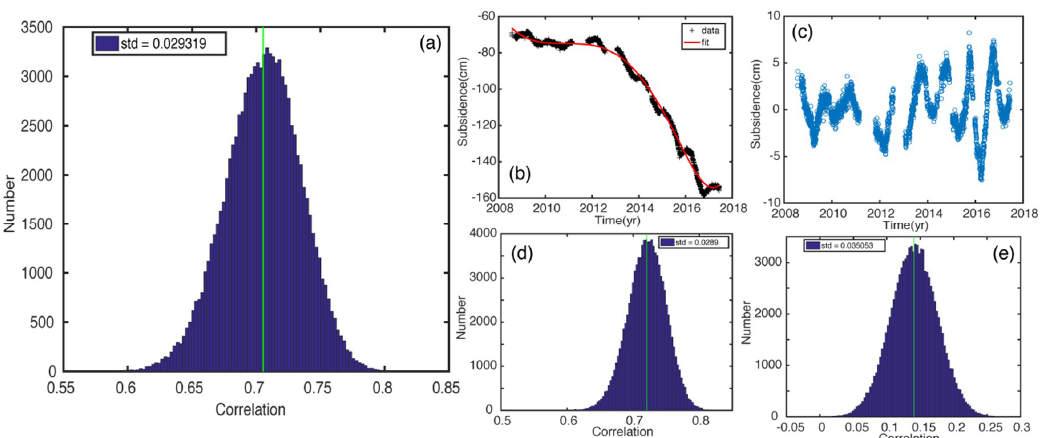
Figure 13. ( a ) Histogram of temporal correlation between GRACE GWA time series in the San Joaquin Valley and Tulare Basin and representative subsidence time series at selected locations. The distribution of the correlation coefficient is realized through a Monte Carlo simulation by taking into account GRACE GWA uncertainties. This gives a sense of how sensitive the estimated correlation is to the error distribution of GWA. ( b ) Spline fit (red) to the subsidence time series (black). The red line represents the secular trend of subsidence. ( c ) The seasonal component of subsidence signals after subtracting the secular trend. ( d , e ) Histograms between GRACE GWA and secular and seasonal variation of subsidence signals, respectively. Note that the correlation coefficient for the secular component is much larger than that for the seasonal component.